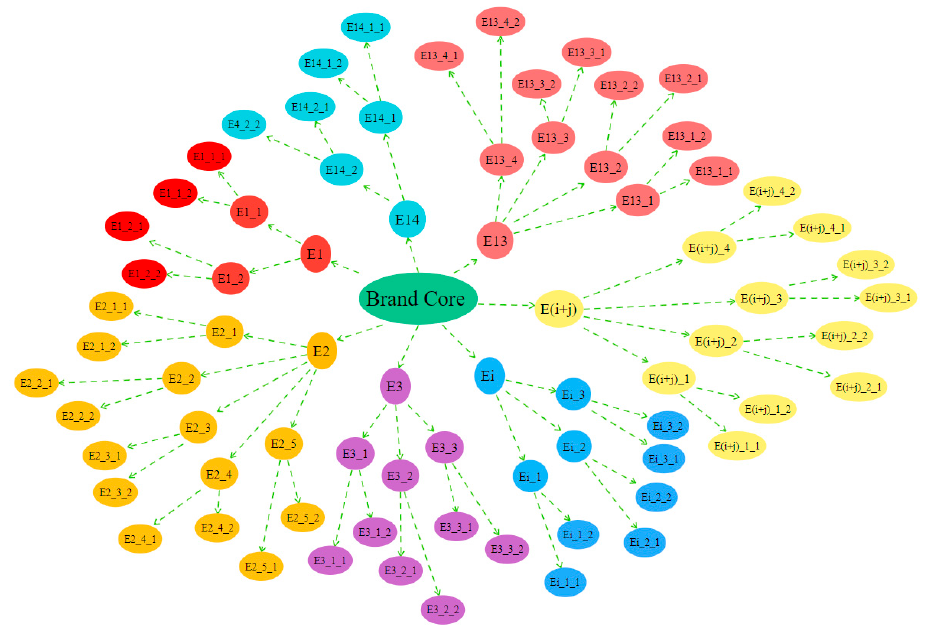
Figure 4. Brand Identity Management Knowledge Graph Framework following David’s “brand identity system”.